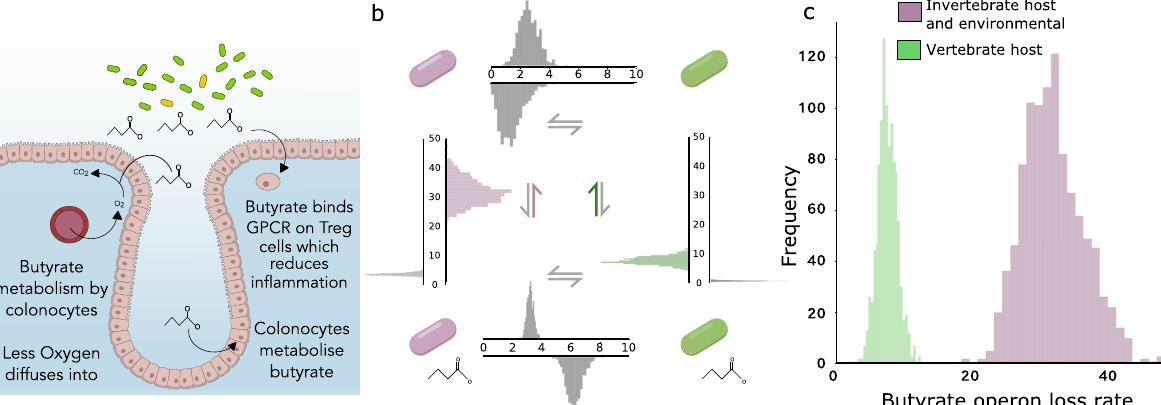
Fig. 4 The pyruvate to butyrate operon is maintained over evolutionary time in host-associated bacteria. a Cartoon of butyrate biology: the short chain fatty acid is produced by members of the mammalian microbiome and is a key energy source for the host colonocytes. The anaerobic environment of the gut is favourable to butyrate producing bacteria and is reinforced by metabolism of butyrate by colonocytes, which lowers the oxygen potential in the gut. In addition, butyrate can reduce in fl ammation via effects on regulatory T cells by binding to G-protein couples receptors (GPCR) 60,61 , ( b ) Evolutionary loss rate of a pyruvate to butyrate operon based upon the genomes of the PATRIC database (Methods). c Posterior distribution for butyrate loss rates for symbionts associated with vertebrate hosts against environmental or invertebrate associated hosts. Source data are provided as a Source Data fi